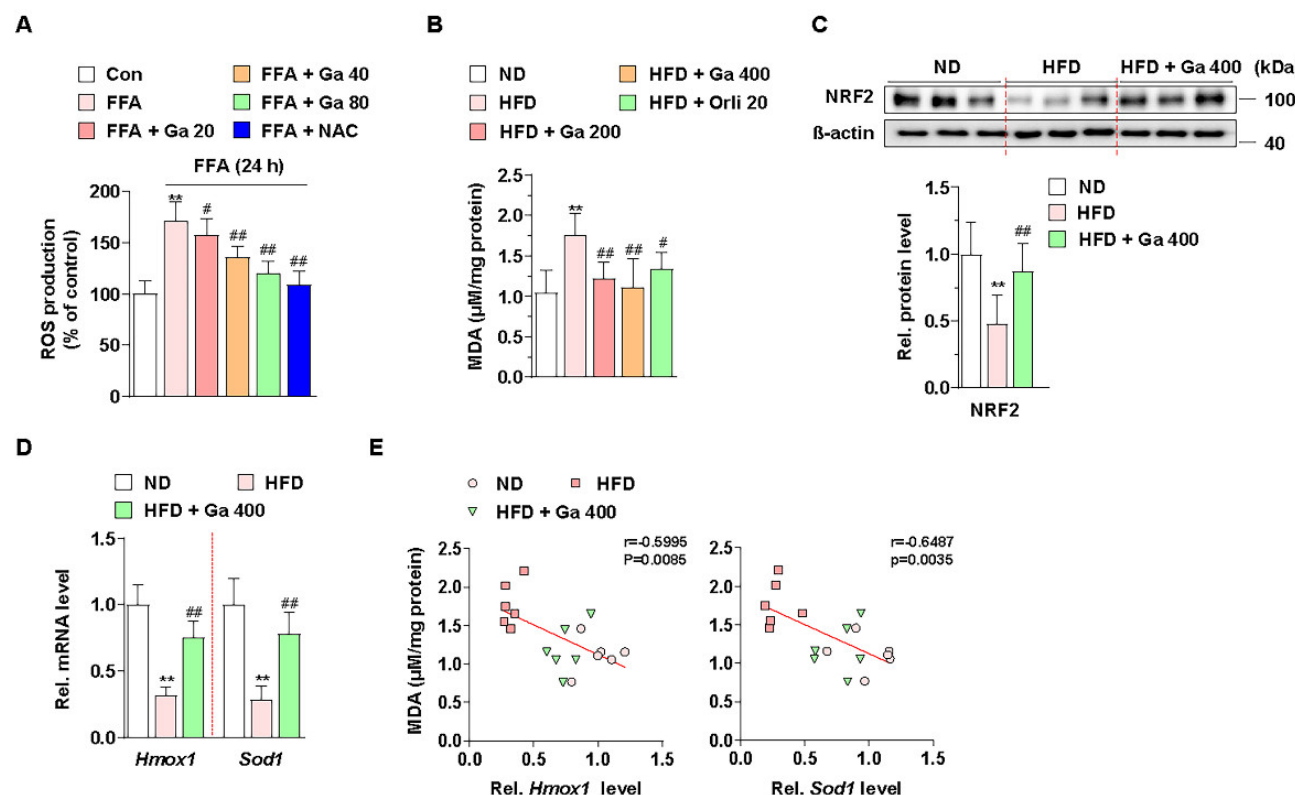
Figure 3. Effect of Garcinia cambogia on HFD- and FFA-induced ROS production, and NRF2 and downstream gene activation. ( A ) Effect of G. cambogia on ROS level in FFA-treated HepG2 cells. Cells were treated with G. cambogia (20–80 µ g/mL) or NAC (5 mM, positive control of antioxidant) for 24 h. ROS production was measured using H 2 DCFDA ( n = 5 per group). ** p < 0.01 vs. Con, # p < 0.05 and ## p < 0.01 vs. FFA. ( B ) Effect of G. cambogia on malondialdehyde (MDA, indicating the intensity of lipid peroxidation) level of serum in HFD-fed mice ( n = 7 per group). Effect of G. cambogia on ( C ) NRF2 expression and ( D ) Hmox1 and Sod1 transcript levels of liver tissues from ND-fed, HFD-fed, and HFD-fed mice administered a high dose of G. cambogia (400 mg/kg) ( n = 6 per group). ( E ) Correlations between MDA level and Hmox1 and Sod1 transcript levels in liver tissues ( n = 6 per group). Each point represents one sample. ** p < 0.01 vs. ND-fed mice, # p < 0.05 and ## p < 0.01 vs. HFD-fed mice. Data are mean ± S.D.